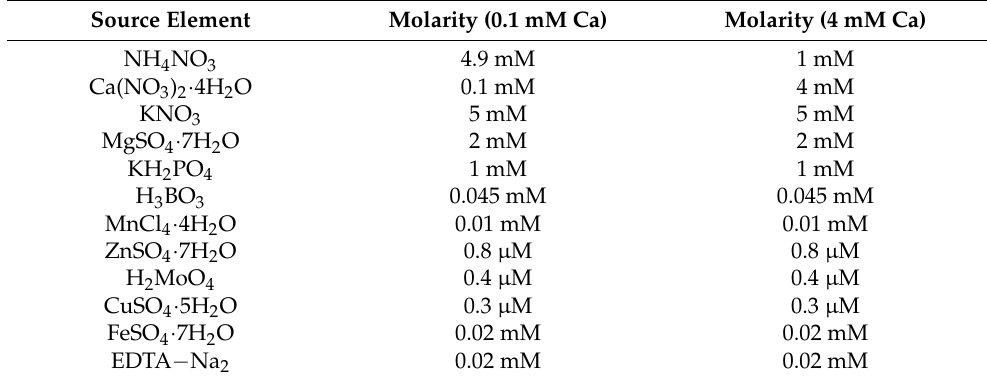
Table 1. Chemical composition of Hoagland nutrient solution under both normal and calcium − deficient conditions.